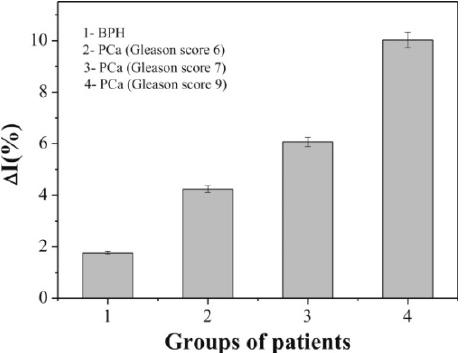
Figure 13. Electrochemical response of the lectin-based nanobiosensor for analysis of serum samples of patients with (1) BPH, (2) PCa (Gleason score (GS) 6), (3) PCa (GS 7) and (4) PCa (GS 9). Reprinted from ref. [191]. Copyright (2016) with permission from Elsevier.